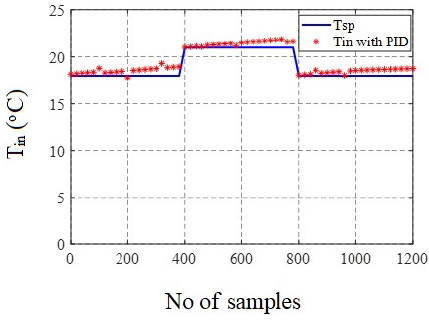
Figure 26. Experimental Results of Relative Temperature T in